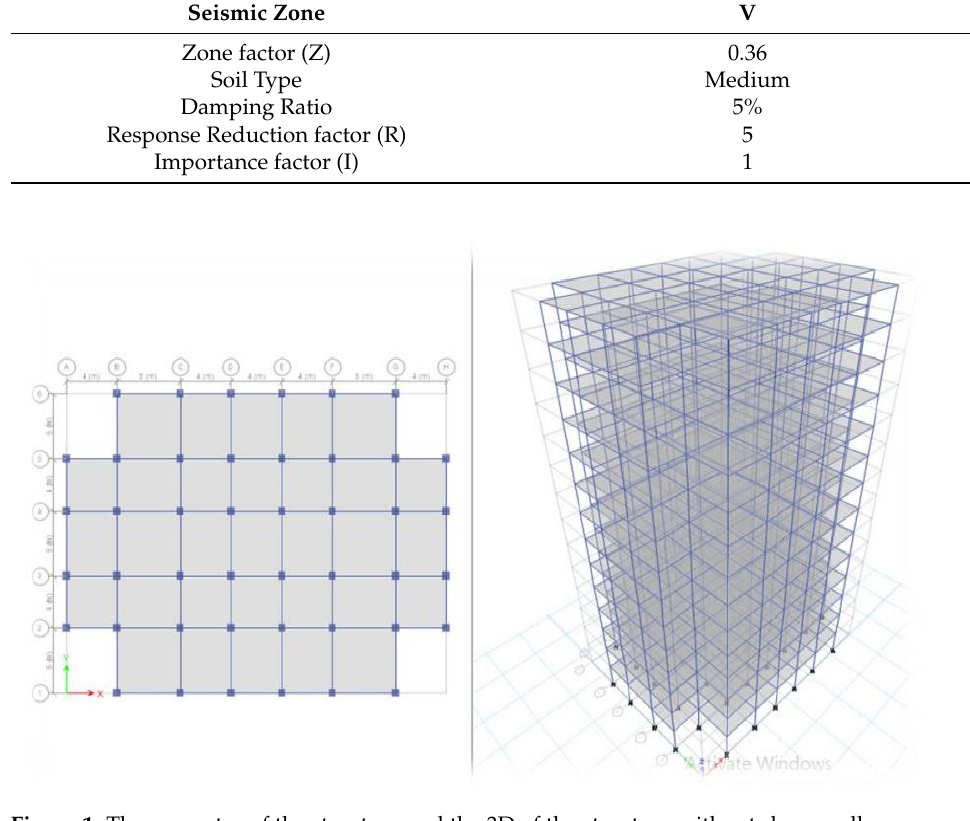
Figure 1. The geometry of the structure and the 3D of the structure without shear walls.